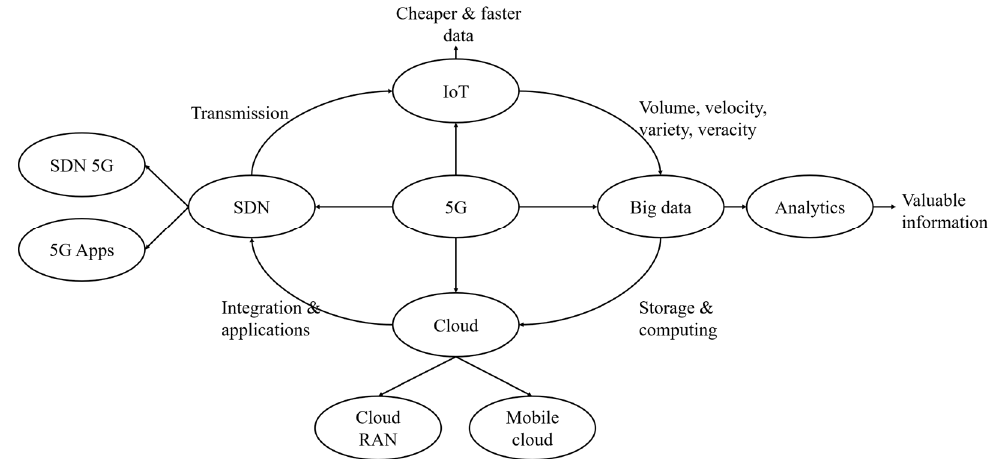
Figure 1. How 5G enables other digital technologies. Source: adapted from Lin, Lin & Tung’s research [33].